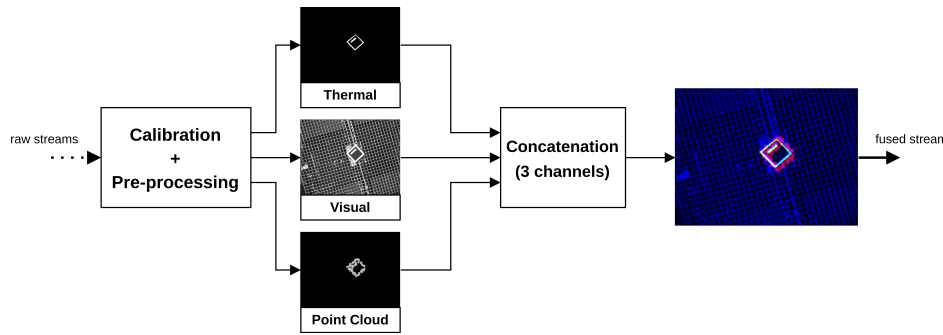
Figure 5. The early fuser